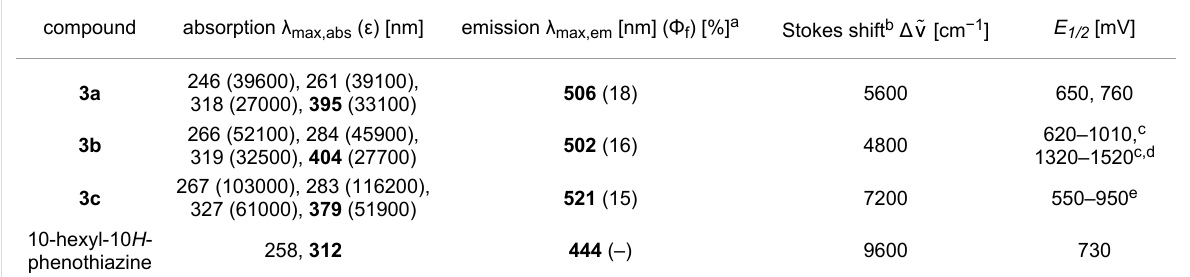
Table 1: UV–vis and emission data and oxidation potentials of thienyl-bridged oligophenothiazines 3 (recorded in CH 2 Cl 2 , T = 298 K; bold values: absorption and emission maxima used for determining the Stokes